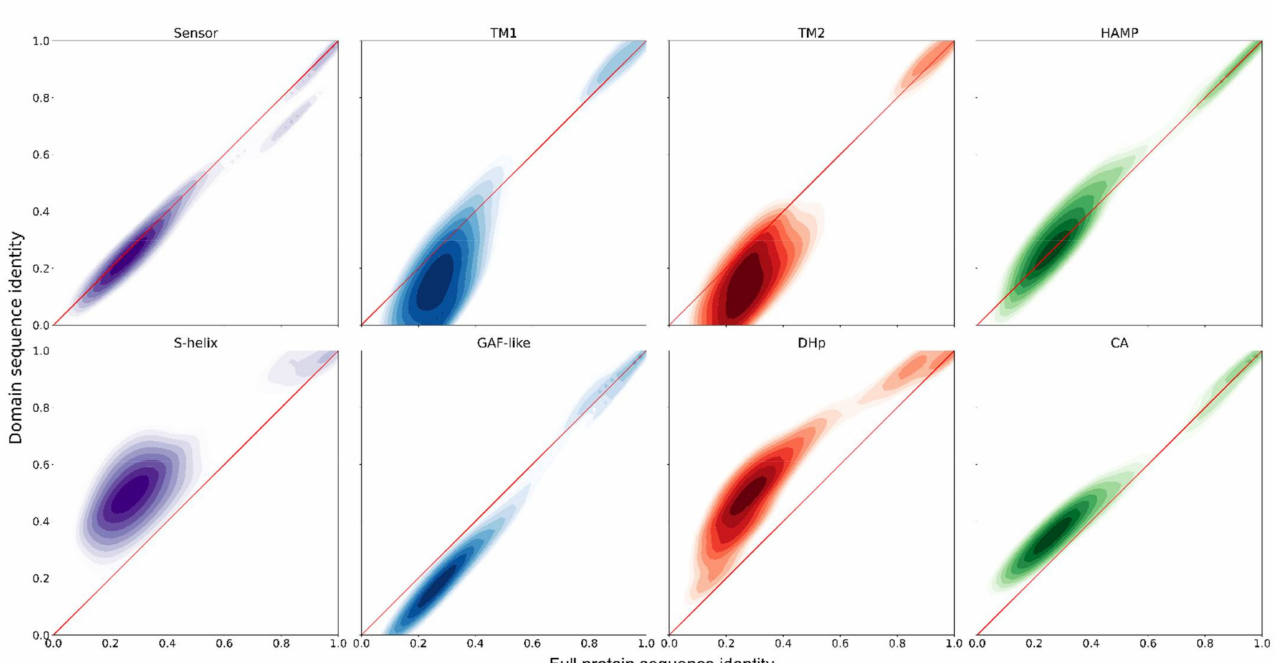
Figure 6. Conservation of NSHK domains relative to conservation of the whole protein. Shown are pairwise sequence identity values for all NSHKs in the dataset smoothed with Gaussian kernel density estimation and transformed to logarith- mic scale. Red diagonals are used as guides: the values above the diagonals correspond to better domain conservation compared to the whole protein, whereas the values below the diagonals correspond to lower relative domain